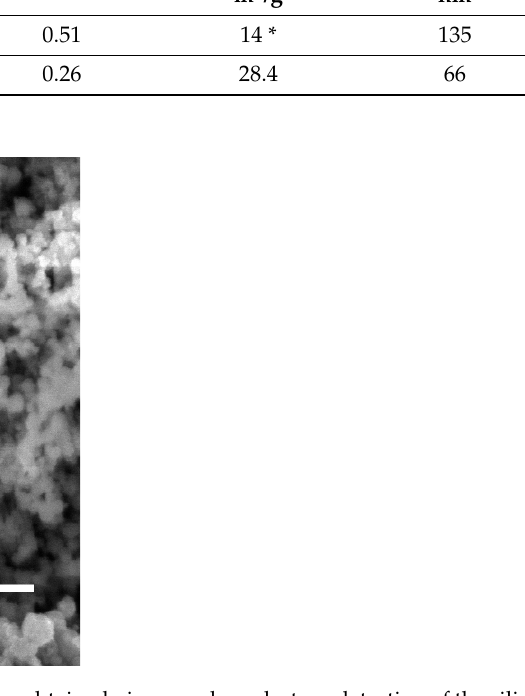
Figure 1. Scanning electron microscopy image obtained via secondary electron detection of the silicon carbide nanopowder.